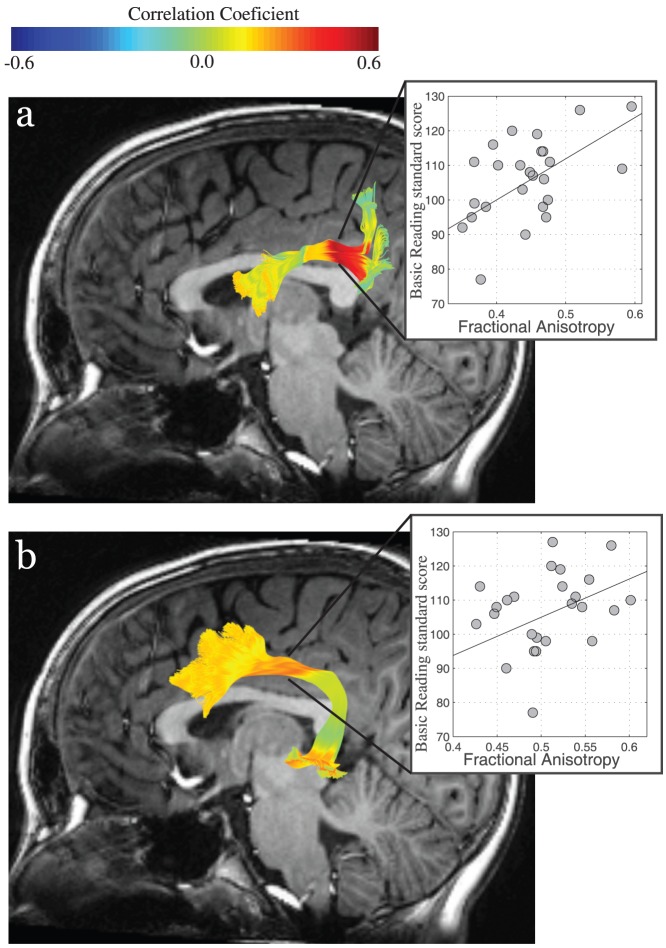
Behavioral Tract Profiles show the correlation between reading skills and FA along the left superior longitudinal fasciculus and left arcuate fasciculus.The correlation between reading skills and FA was computed at each point along the Tract FA Profile for the (a) left superior longitudinal fasciculus and (b) left arcuate fasciculus in the children born preterm. The resulting Behavioral Tract Profile is mapped to the fiber tracts of a single representative subject. Colors correspond to the magnitude of correlation between reading scores and FA at each of 100 equidistant points along the tracts for the children born preterm. The correlations were not uniform along the tracts. Scatter plots show the association between FA (x-axis) and Basic Reading Standard Scores (y-axis) for the point of maximal correlation.